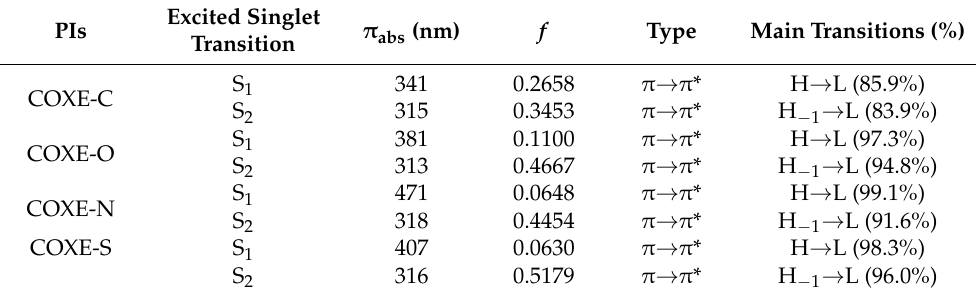
Table 2. TD-DFT data relative to the two lowest energy electronic transitions of COXEs.